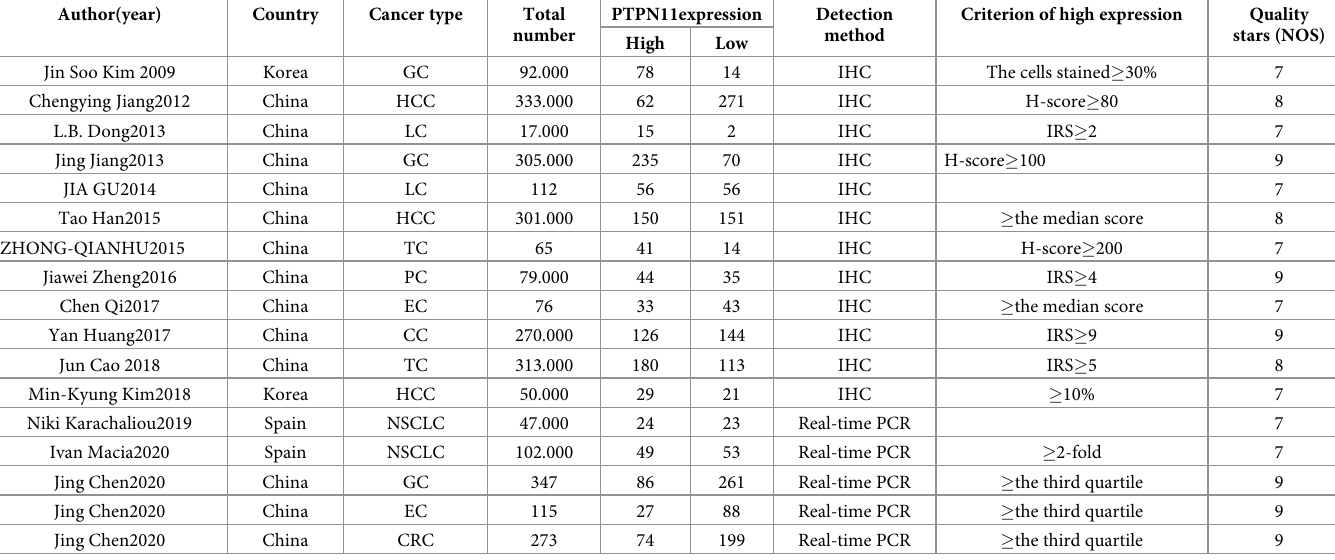
Table 1. The basic information and data of all included studies in the